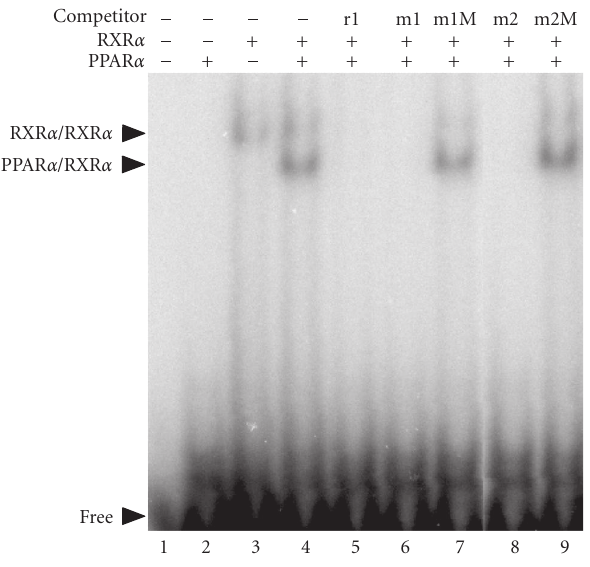
Figure 4: Both PPRE-1 and PPRE-2 serve as e ff ective binding sites for the PPAR α /RXR α heterodimer. EMSA was performed using MBP-PPAR α and GST-RXR α expressed in E coli , using the rat AOX PPRE (corresponding to PPRE-1), as a probe. Competitors were rat AOX PPRE (unlabeled probe; r1), mouse PPRE-1 (m1) or its mu- tant (m1M), and mouse PPRE-2 (m2) or its mutant (m2M). Shifted bands with PPAR α /RXR α heterodimer and RXR α homodimer are indicated, together with that of free